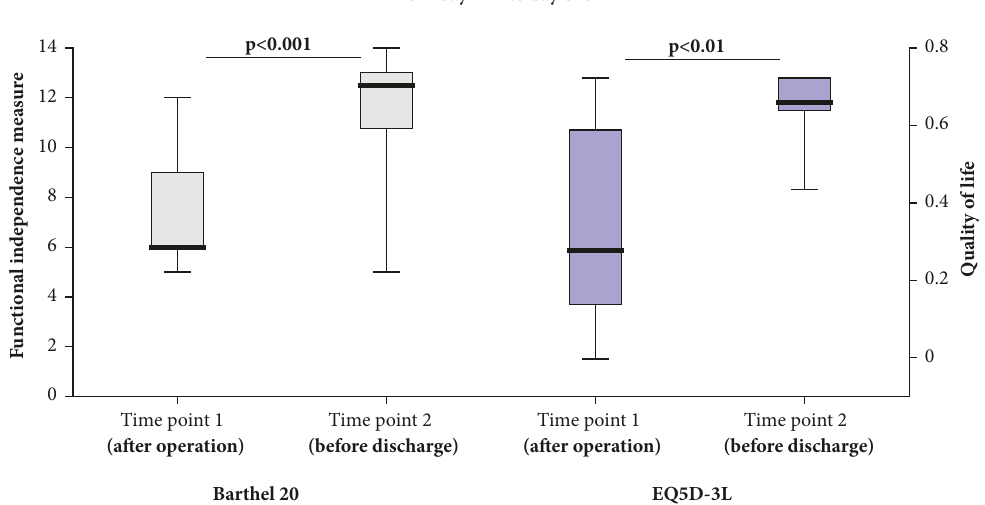
Figure 7: After an operation for stabilization of the proximal femur, the functional independence measured by the Barthel 20 index (left) and the quality of life measured by the EQ5D-3L (right) is increasing during the first couple of